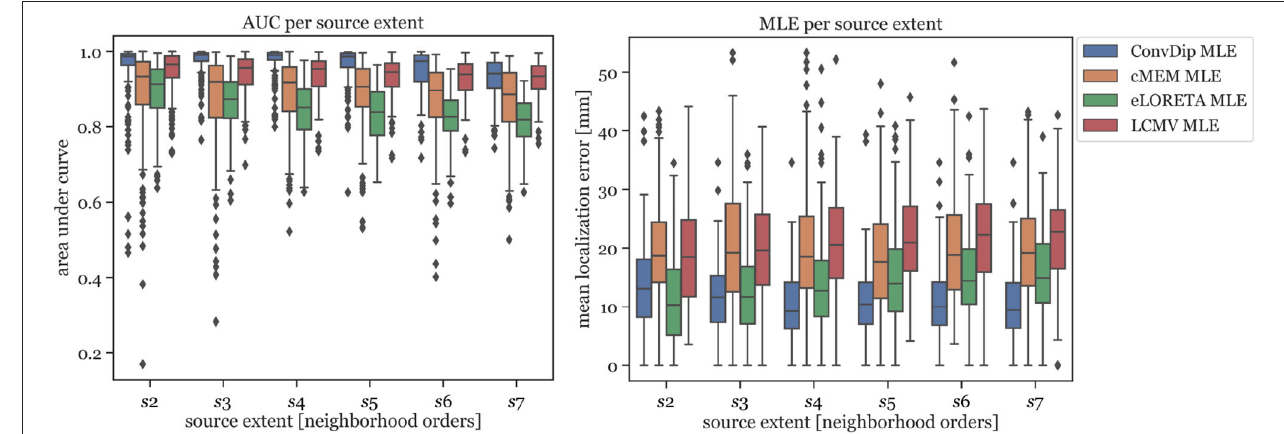
FIGURE 2 | Area under the curve and mean localization error for each inverse solution algorithm grouped by the source extent. AUC reflects capability of finding source at correct location, estimating its size and reducing false positives. MLE reflects the capability to correctly localize the center of the source cluster. Simulations used for this analysis contained only a single source cluster per sample with varying size from two to seven neighborhood